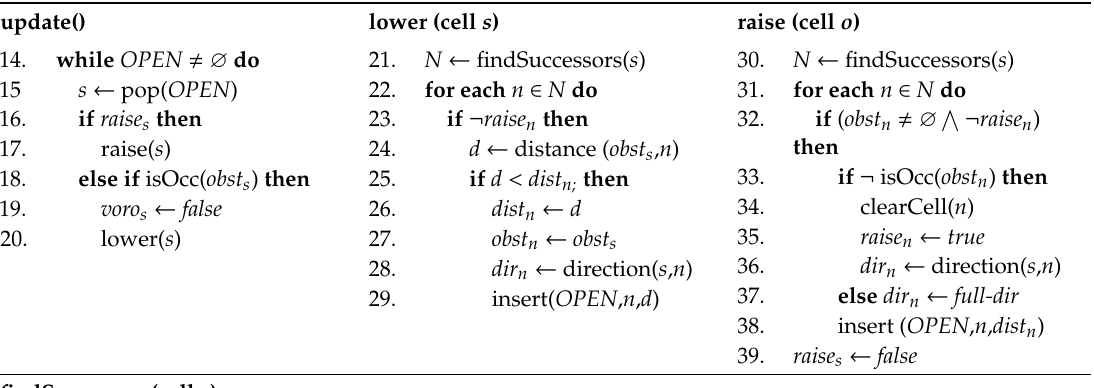
Table 2. The pseudocode for updating the Euclidean distance